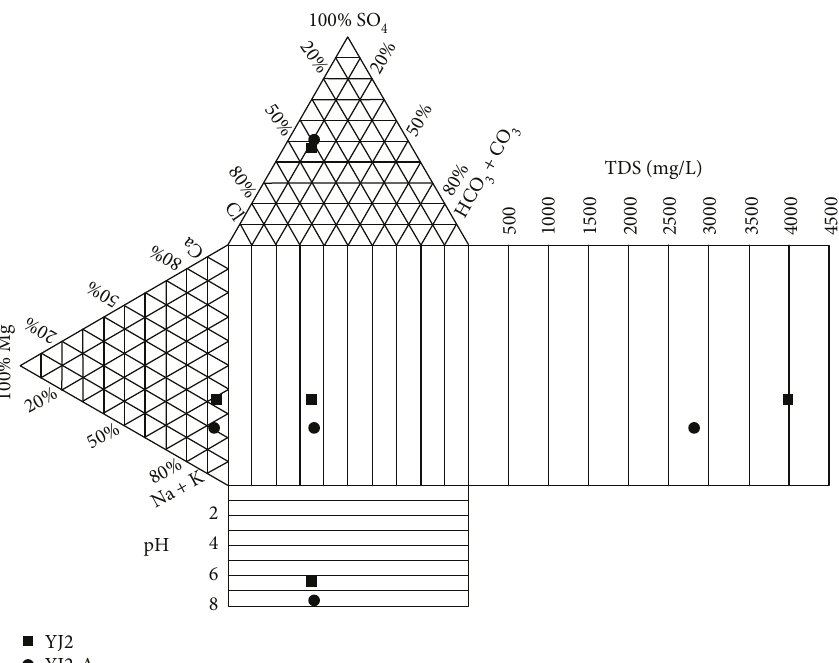
Figure 2: Durov diagram showing the Madeng hot spring water samples — YJ2: water sample of the hot spring taken in 2014; YJ2-A: water sample of the hot spring from Local Chronicles Compilation Committee of Yunnan Province